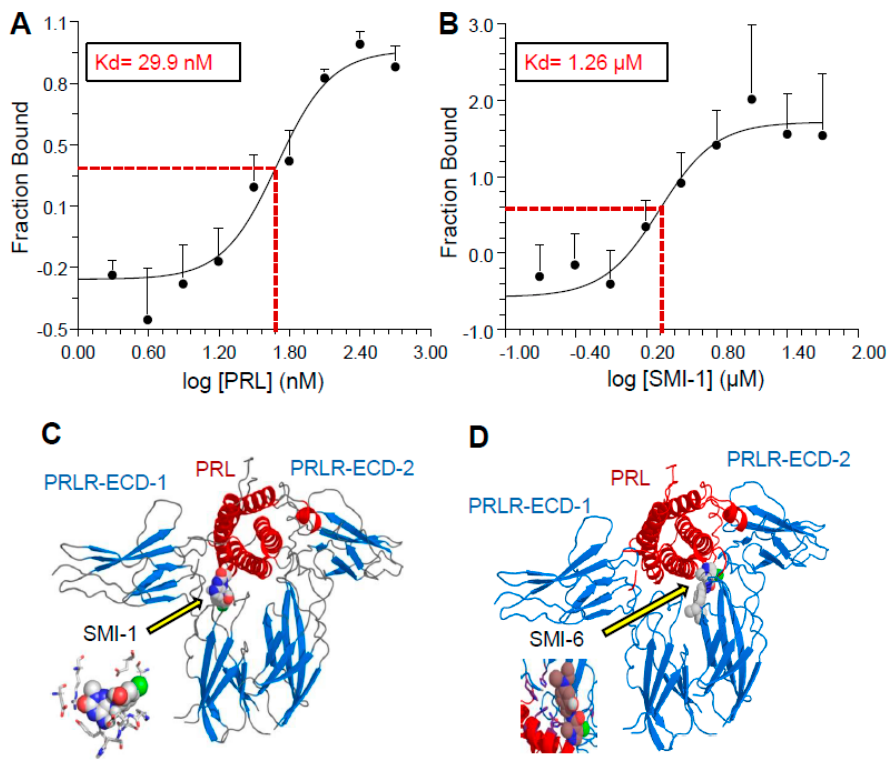
Figure 2. Binding curves of hPRL ( A ) and SMI-1 ( B ) to PRLR-ECD, as determined by microscale thermophoresis. The dissociation constants (Kd) were calculated using the Hill equation method. Error bars represent SEM of 3 measurements. Panels ( C , D ) show docking simulations of SMI-1 and SMI-6, respectively, to dimerize ECD (blue) of the PRLR bound to PRL (red). Insets show binding details of the SMIs.